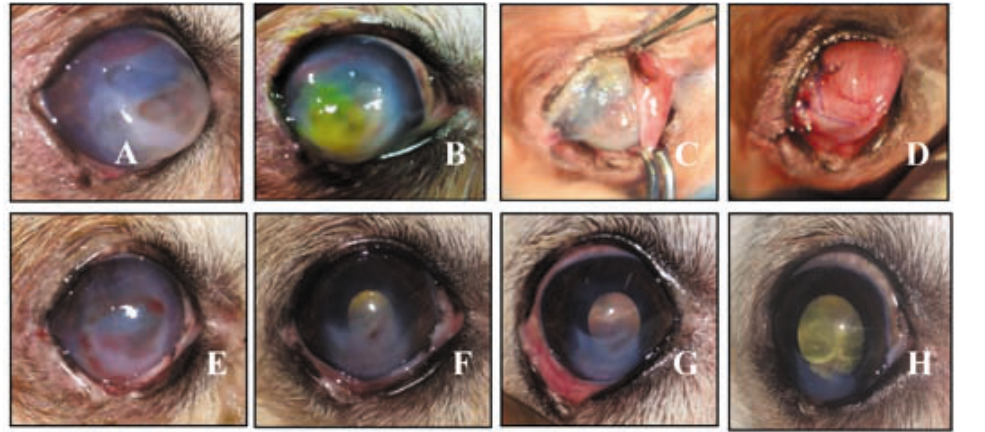
Fig.1: (a) Keratomalacia, (B) Fluorescein dye-stained cornea, (c) Canine amniotic membrane layered cornea, (D) Third eyelid flap, (E) Appearance of cornea on day 10, (F) Appearance of cornea on day 20, (G) Appearance of cornea on day 30, (h) Appearance of cornea on day